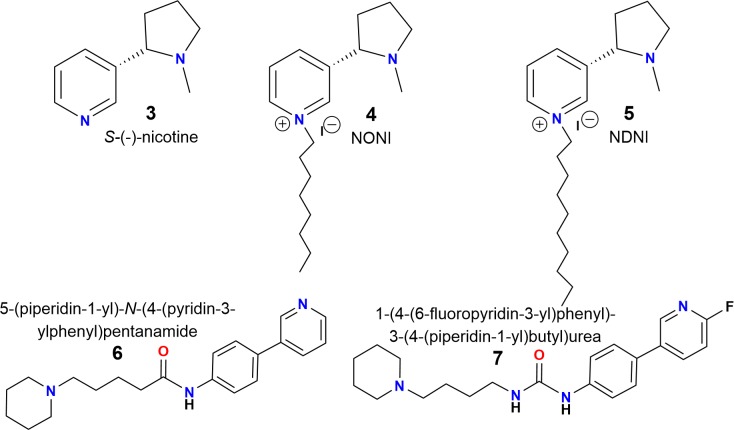
Chemical structures of S-(-)-nicotine (3), N-n-alkylnicotinium analogs NONI (4) and NDNI (5) and piperidine derivatives (6) and (7) (Crooks et al., 1995; Roy et al., 1999; Wilkins et al., 2002).